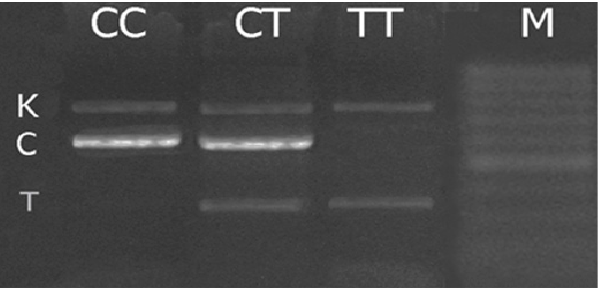
Figure 1. Electrophoregram of the NRF2 rs35652124 amplification products. К —amplification con